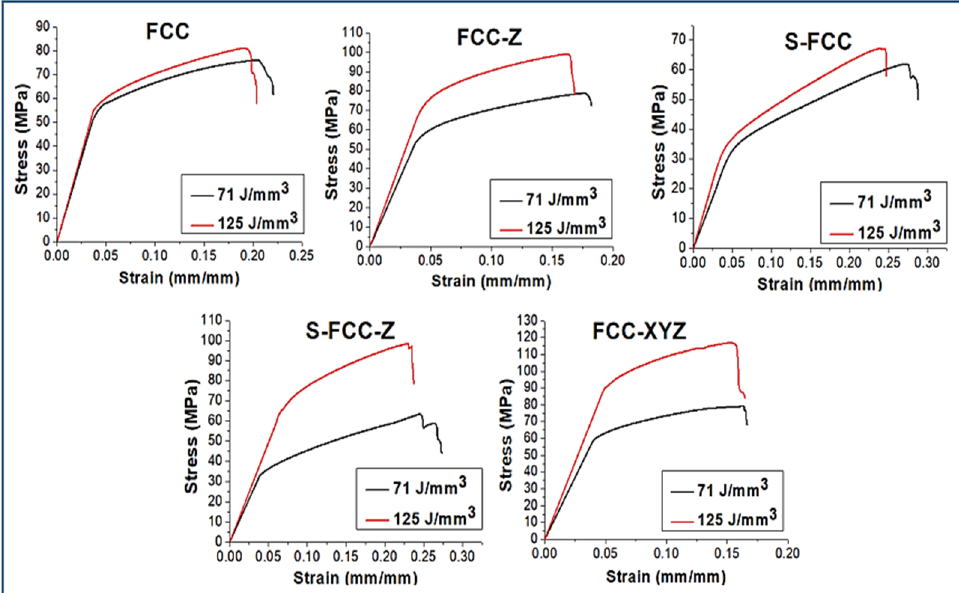
Figure 8. The comparison of tensile stress–strain curve of FCC-based lattices affected by laser energy densities.